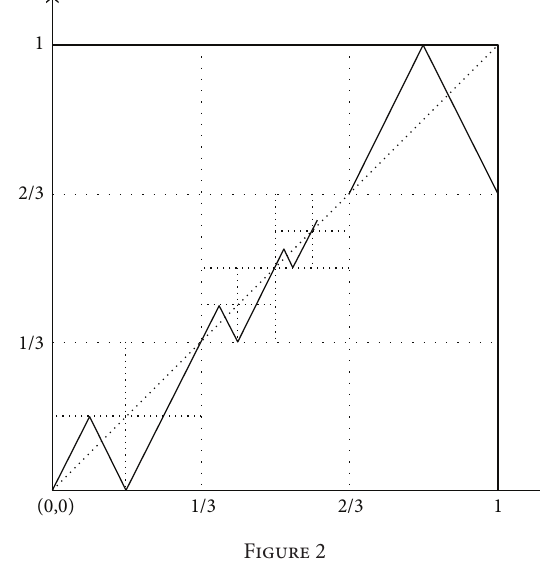
Example 20. 𝑓 : 𝐼 → 𝐼 is given by 𝑓| [0,1/2] which is the tent map and 𝑓| [1/2,1] which is linear. It is not difficult to get that 𝑓 is sensitive but is not Li-Yorke sensitive ( 1 is a distal point). The following example is an interval map which is spatiotemporal chaotic but is not Li-Yorke sensitive. Example 21. 𝑓 : 𝐼 → 𝐼 is given by 𝑓| [0,1/6] , 𝑓| 𝐼 which are the tent maps, and 𝑓| [1/6,1/3] , 𝑓| 𝐼 󸀠